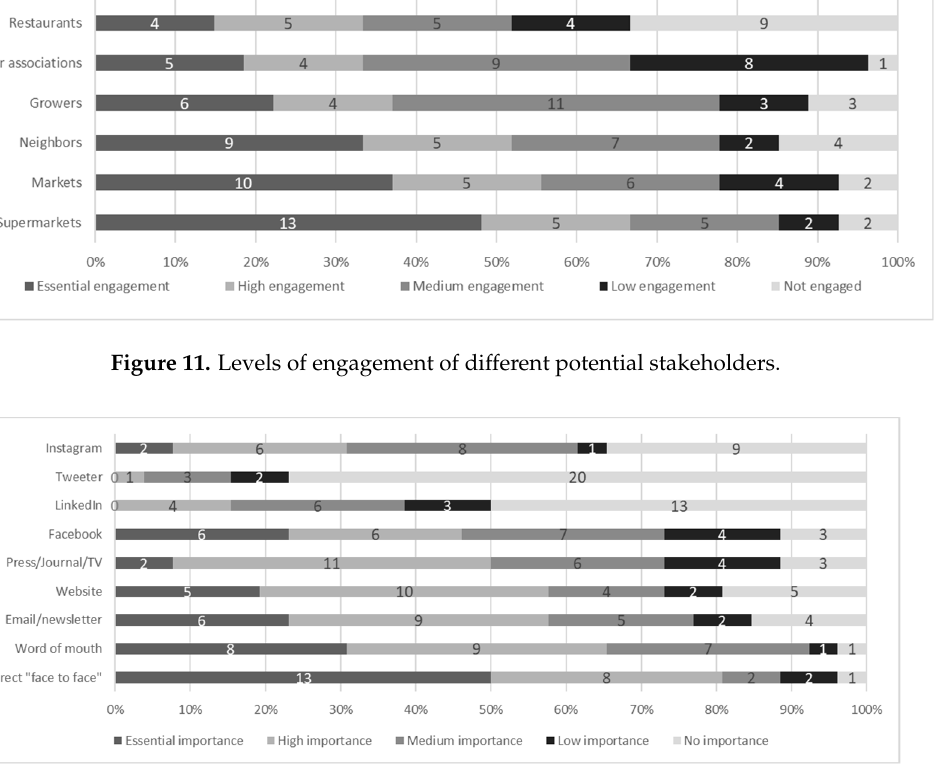
Figure 12. Levels of competition of different potential competitors.